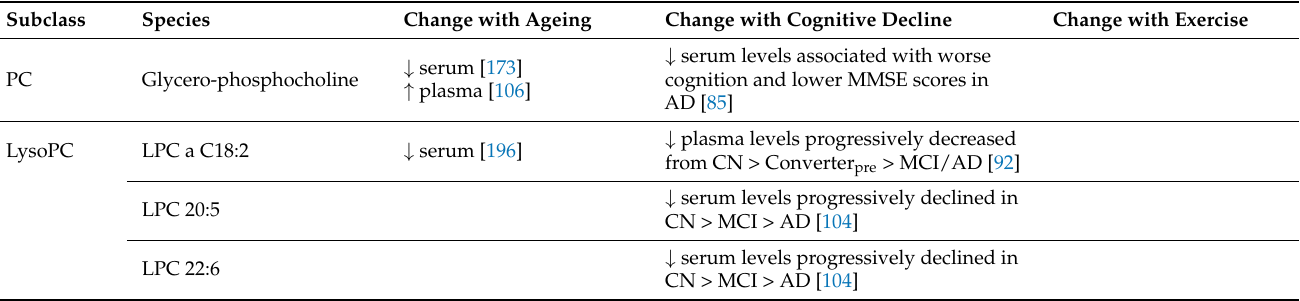
Table 3. Changes in phospholipids with ageing, cognitive decline and exercise in